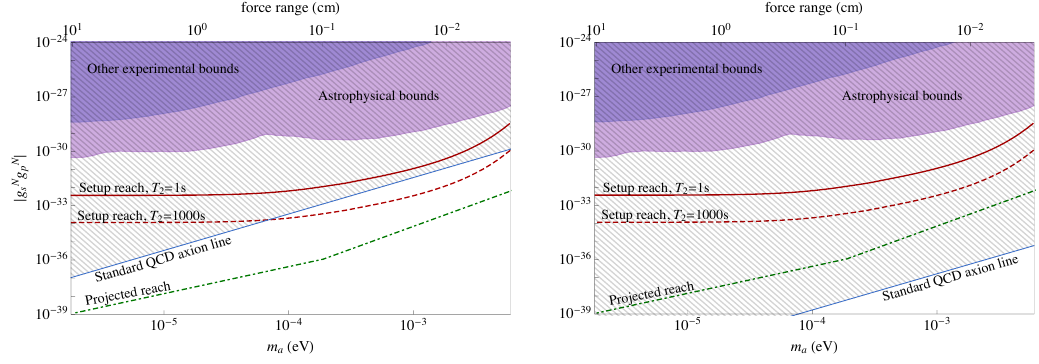
Figure 3 . Bounds on the monopole-dipole coupling between nucleons from QCD axion-mediated forces. The solid and dashed red curves are the projected sensitivities of the ARIADNE setup for various settings, discussed in ref. [21]. The green dot-dashed curve is a future projection for a scaled-up setup. Other bounds [52] come from combined g N the monopole-dipole coupling for a standard QCD axion assuming j g s j (cid:24) 10 (cid:0) 21 ( m a = 10 (cid:0) 4 eV) (left) and j g s j (cid:24) 10 (cid:0) 26 ( m a = 10 (cid:0) 4 eV) (right). The parameter space for our QCD axion model (hashed region) extends above the standard QCD axion